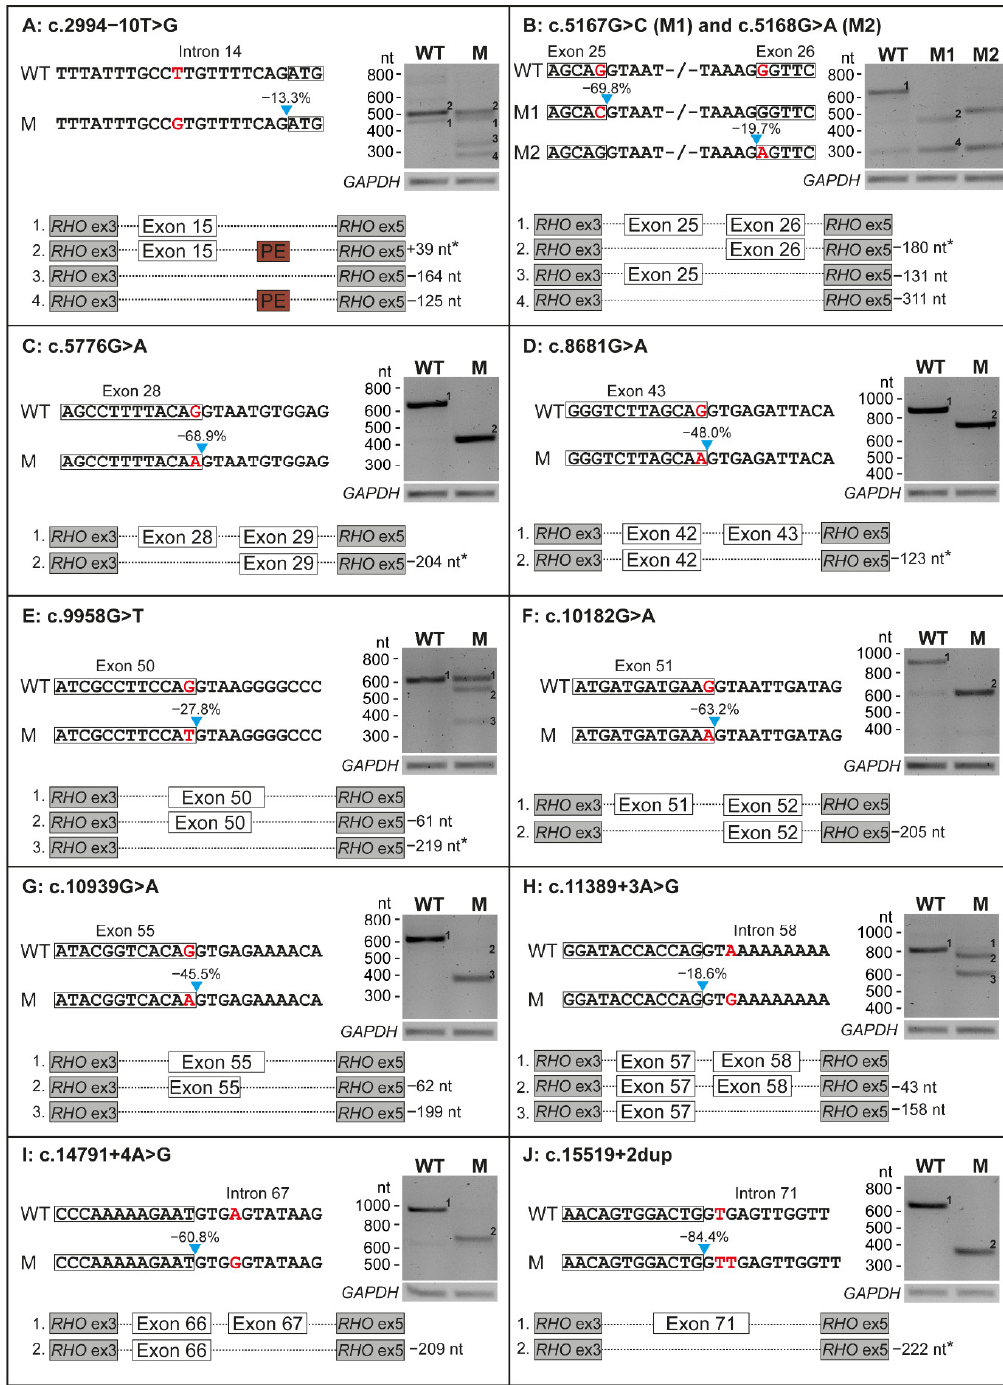
Figure 2. Results on splicing of all 11 variants that were tested in minigene splice assays. For each variant, part of the wildtype (WT) and the mutant (M) construct is depicted. The location of the variant is indicated in red and the predicted decrease in splice site strength is presented above the blue arrow. The results of transfection with both WT and M constructs in HEK293T cells and subsequent RT-PCR and agarose gel electrophoresis are shown for all variants. A schematic overview of all the mRNA products that resulted from transfection with both constructs is visualized. Effects resulting in an in-frame deletion or insertion are marked with an asterisk. GAPDH was used as loading control. Ex: exon, nt: